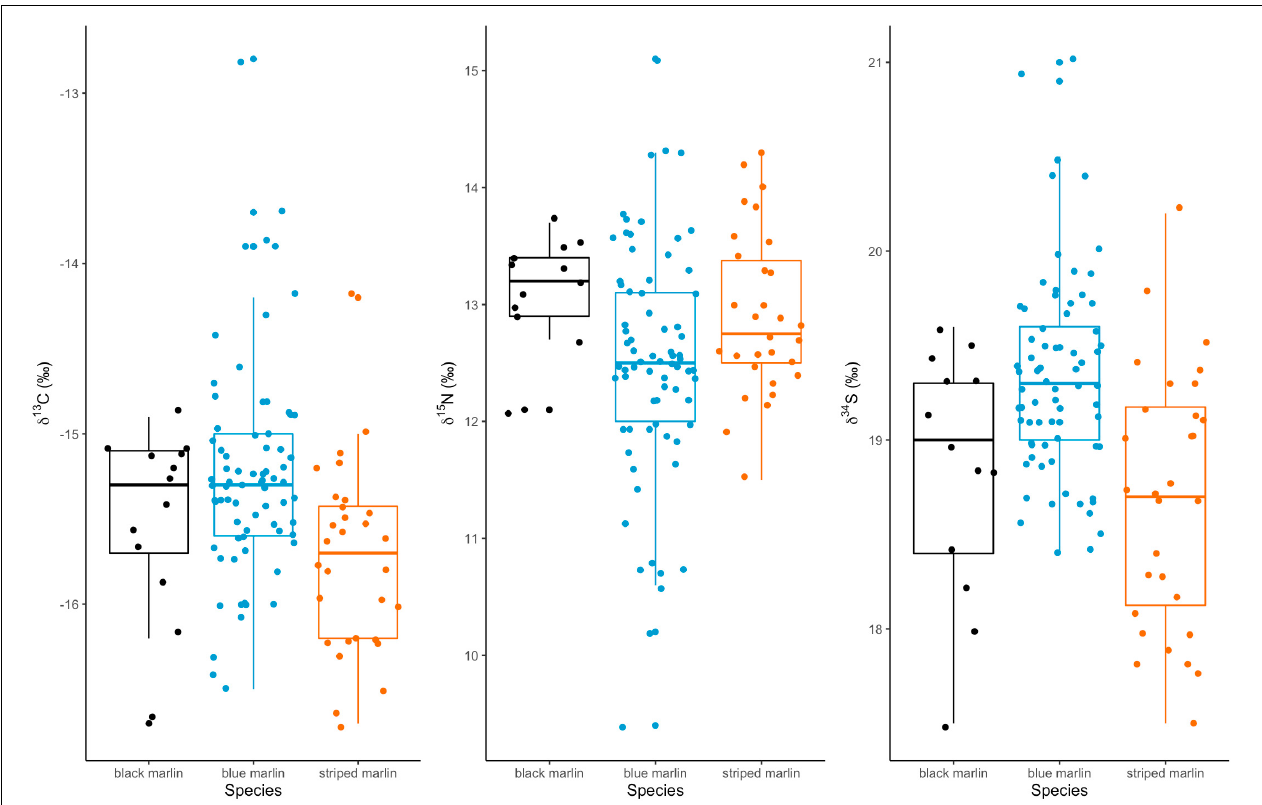
FIGURE 1 | Boxplots of mean isotope ( δ 13 C, δ 15 N, and δ 34 S) values for three marlin species: black marlin ( Istiompax indica ), blue marlin ( Makaira nigricans ), and striped marlin ( Kajikia audax ).